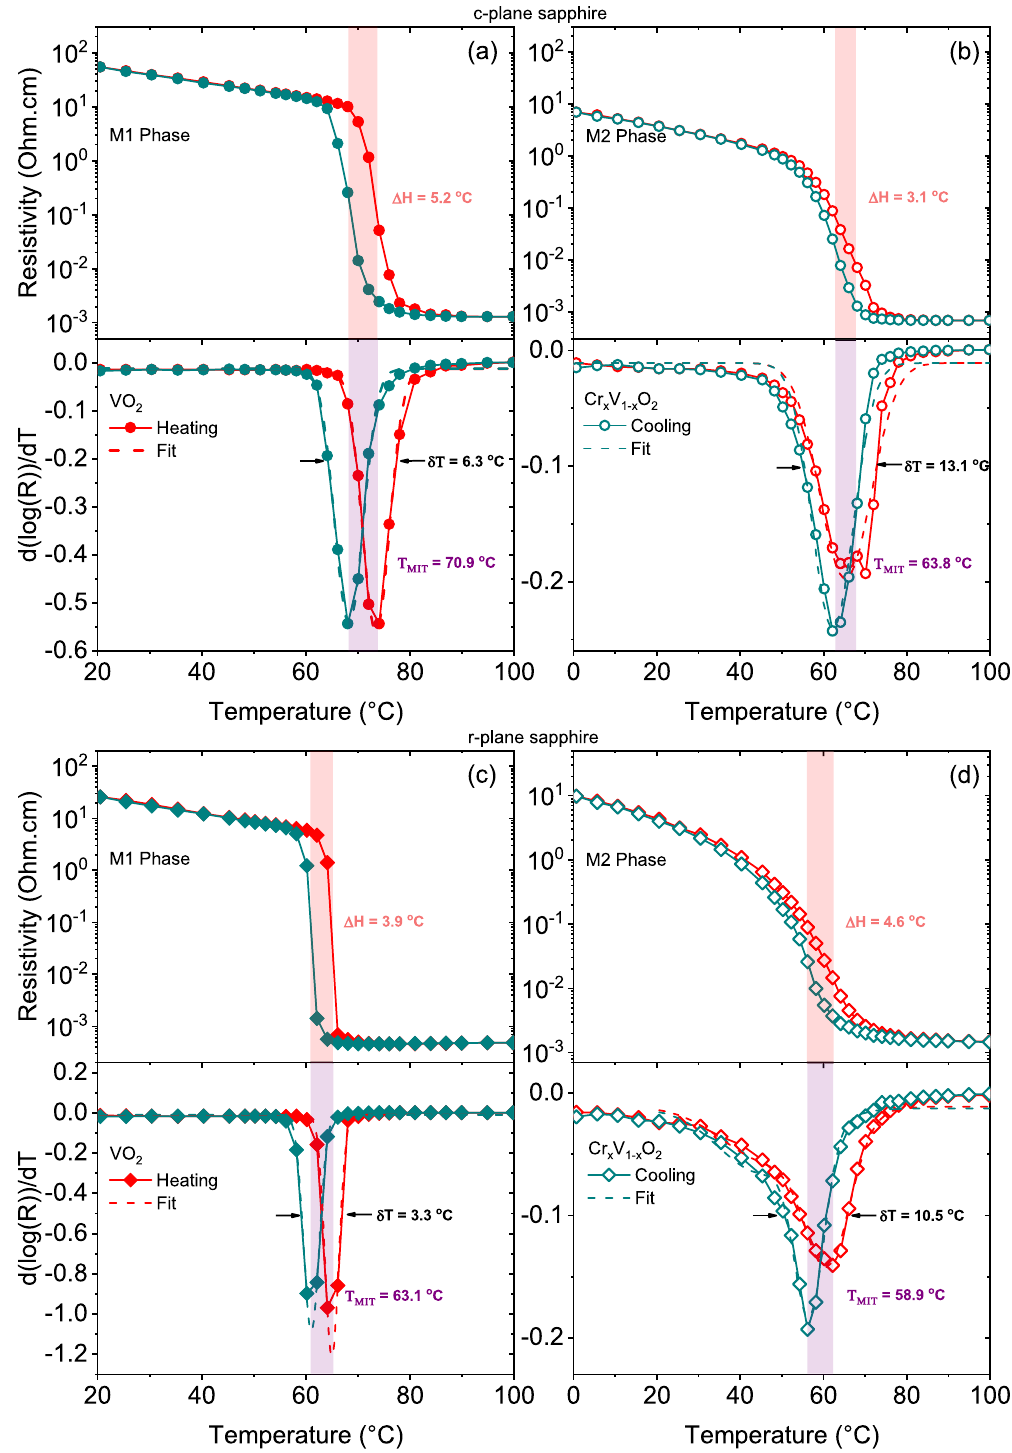
Figure 4. Resistivity and the derivative plot of the temperature-dependent resistivity of undoped ( a , c ) and Cr-doped VO 2 ( b , d ) deposited on c- and r-sapphire for the cooling and heating cycles showing the hysteresis width, (cid:31) H (difference between T MIT of both thermal cycle), the transition width, δ T (the full-width half- maximum) and the transition temperature, T MIT